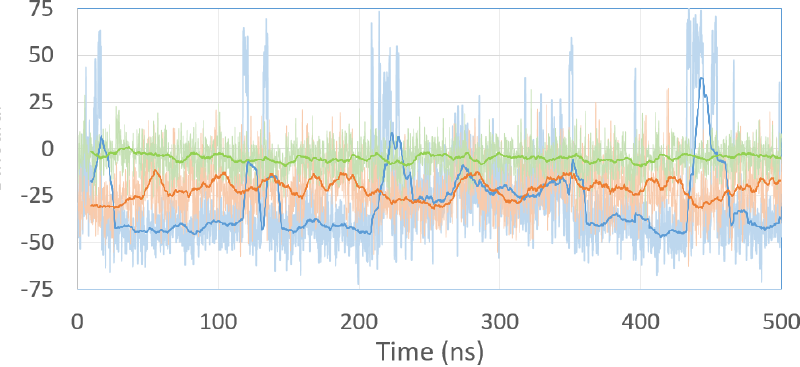
Figure 5. Propeller twist angle between Guanine analogs of the ICL-A (orange) and ICL-B (blue) models and the propeller twist angle of the G-G base pair of the native (green) model during 500 ns of MD simulation. The solid line represents the moving average of each simulation.